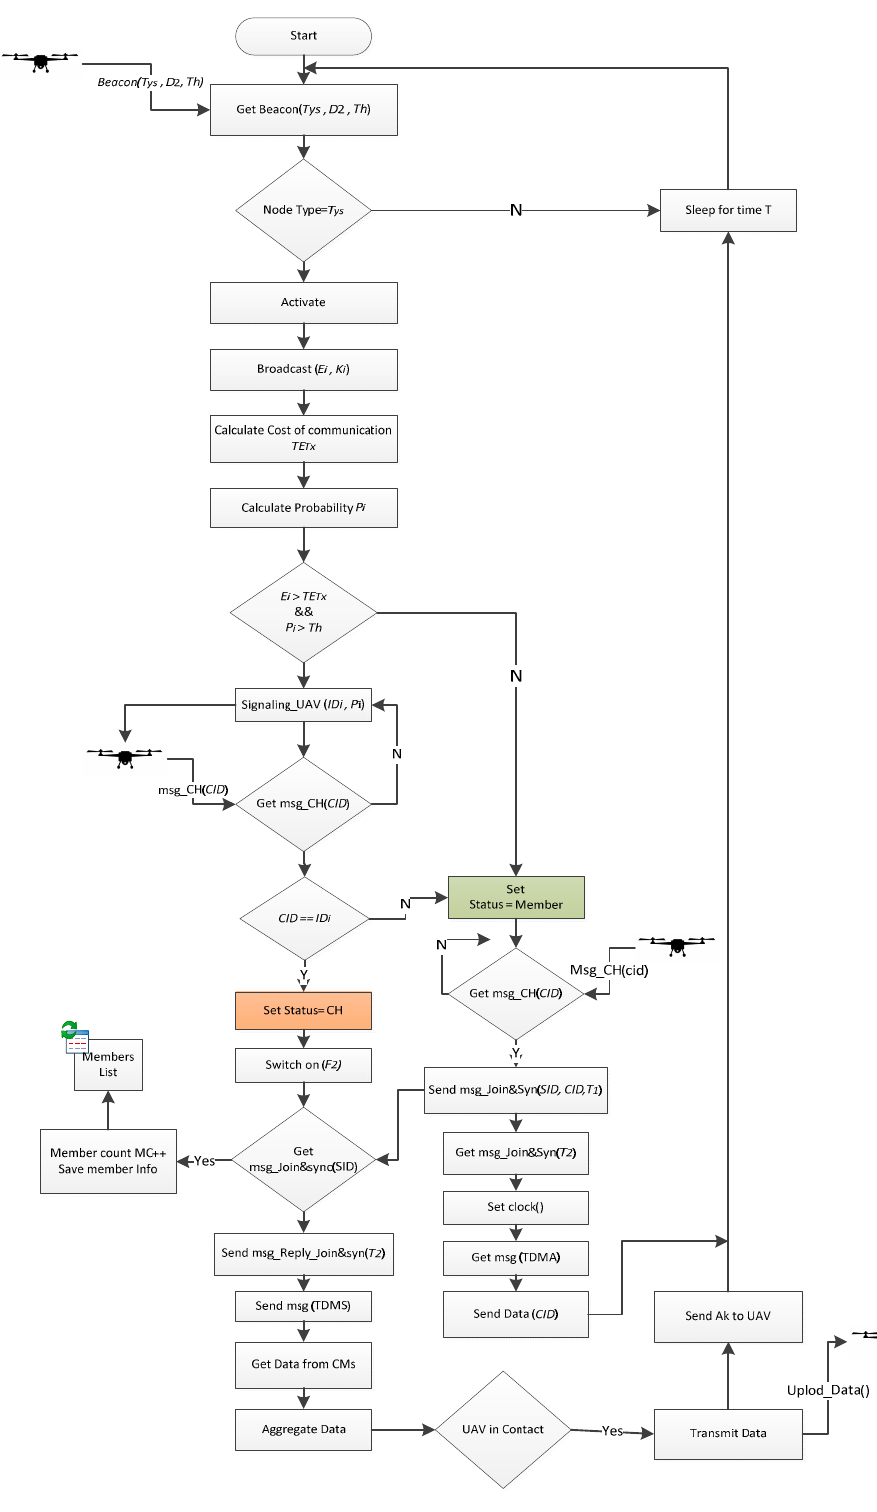
Figure 3. Working flow of sensor node.